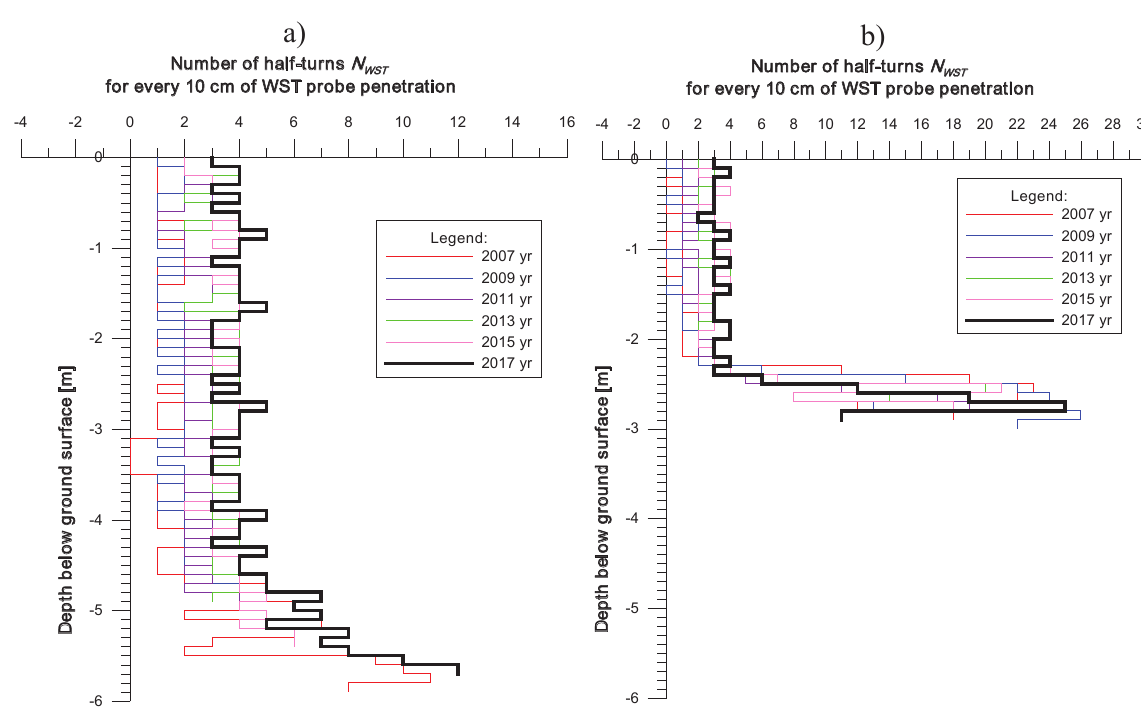
Fig. 7. WST probing results between counterforts P4 and P5 a) WST-7, b) WST-8 Figure 7 : WST probing results between counterforts P4 and P5: a) WST-7 and b) WST-8.